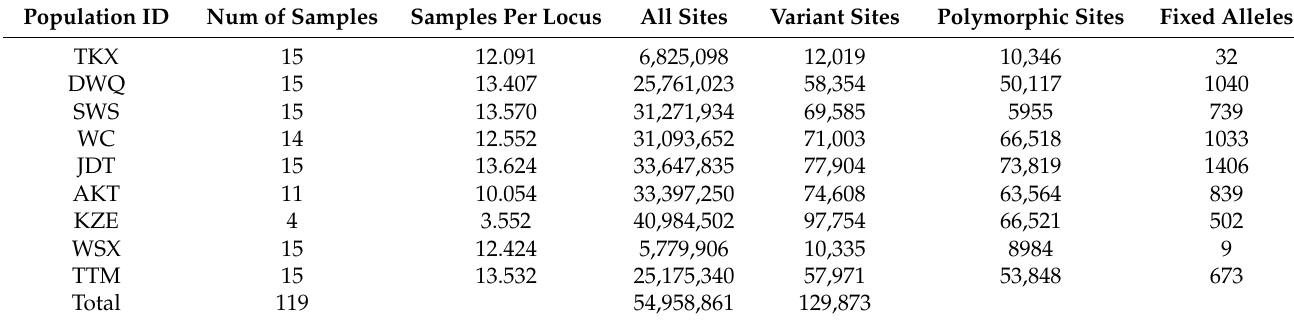
Table 1. The summary of loci identified with the Stacks pipeline among nine populations.